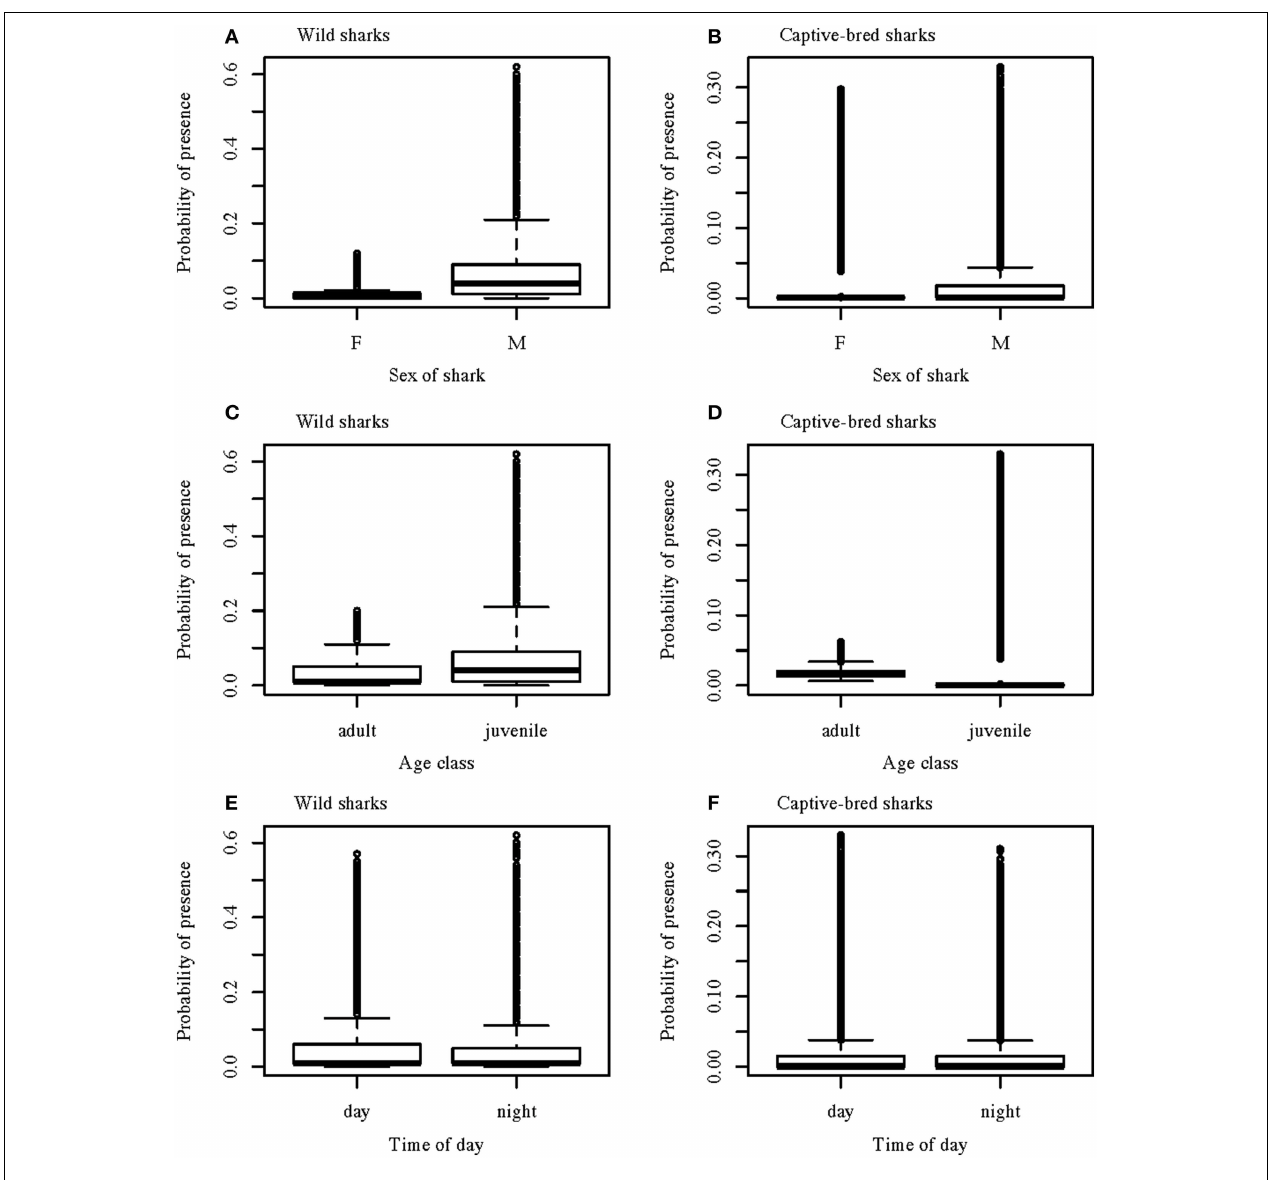
FIGURE 4 | Boxplots of the predicted values from the best GLMM models for the probability of wild and captive-bred wobbegongs being present at CTBAR against sex of the shark (A,B); age class